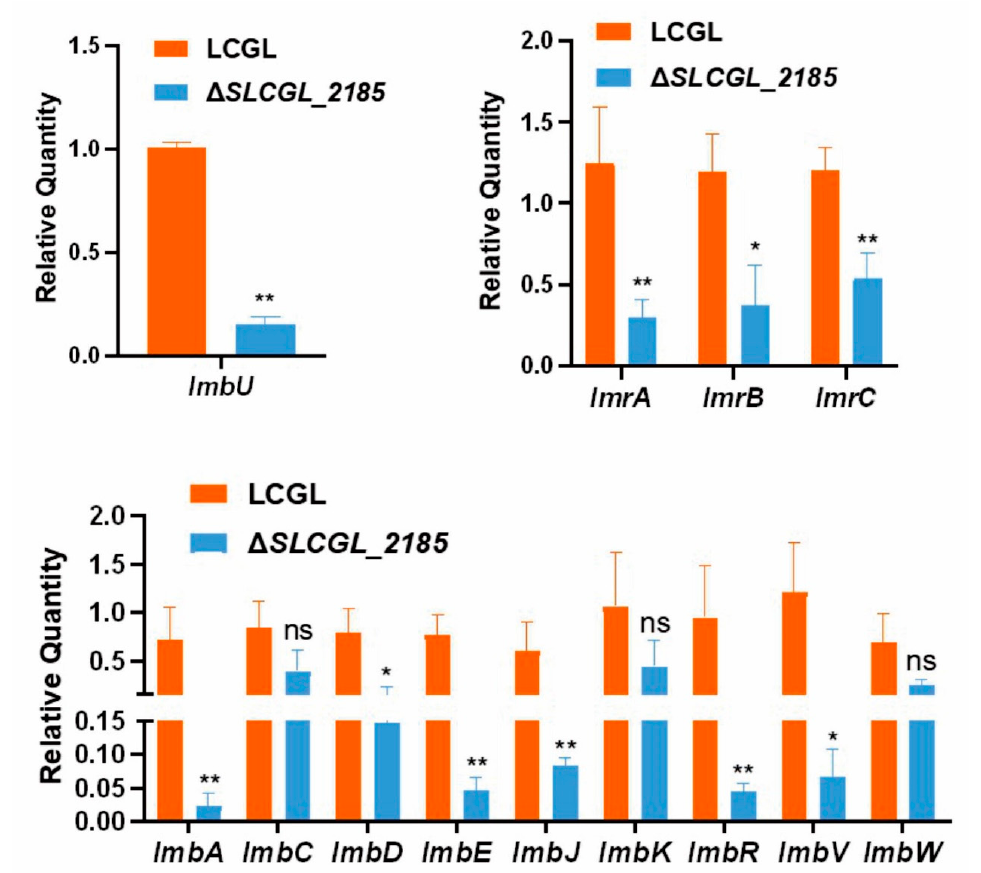
Figure 7. RT-qPCR analysis of lincomycin biosynthetic genes in LCGL and ∆ SLCGL_2185 . The mean values of three replicates are shown, with the standard deviations indicated by error bars. * p < 0.05, ** p < 0.01.